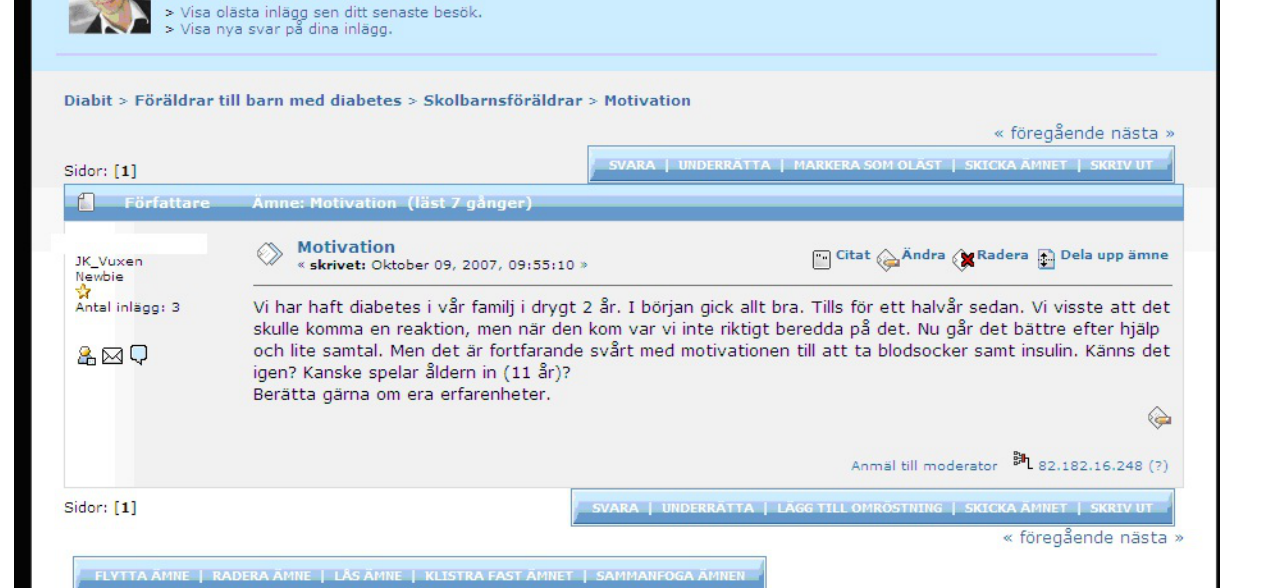
Figure 3. Screenshot from the Diabit portal. Discussion